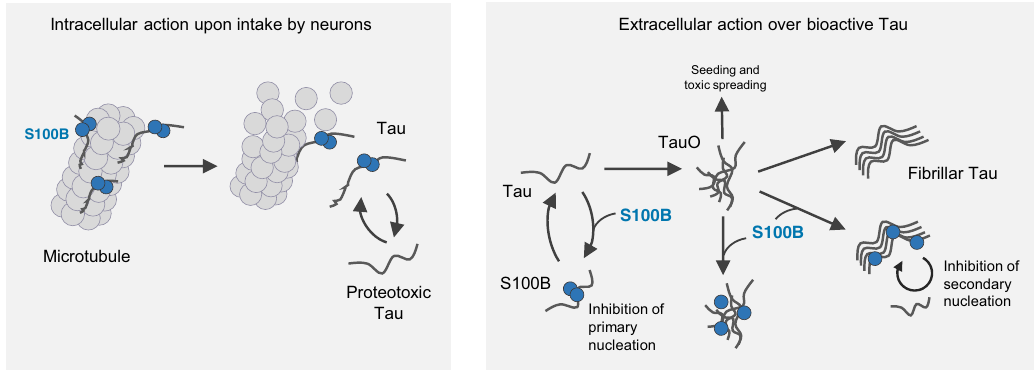
extracellular (right) interactions established between S100B and tau. Inside cells, S100B operates as a microtubule-regulating factor, likely acting as